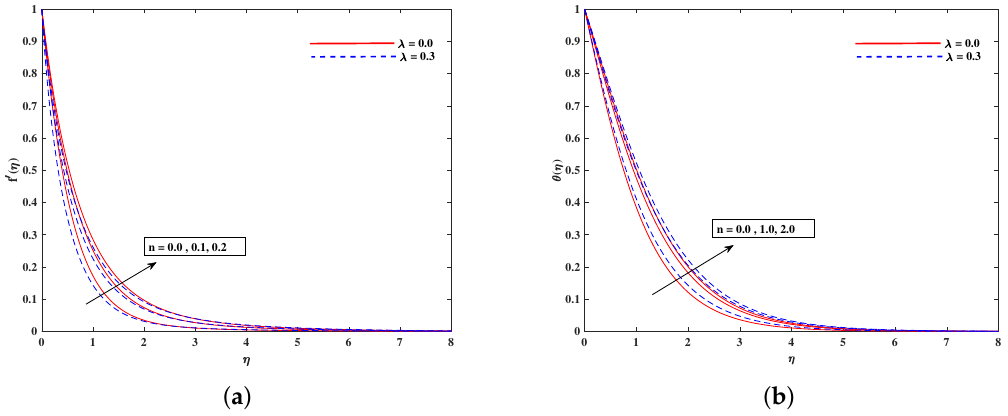
Figure 3. Fluctuation of n on velocity f (cid:48) ( η ) ( a ) and temperature profile θ ( η ) ( b ).